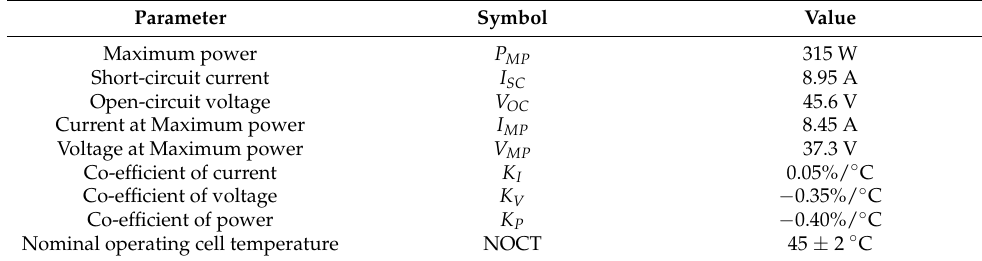
Table 3. Datasheet values of a 315 Wp PV